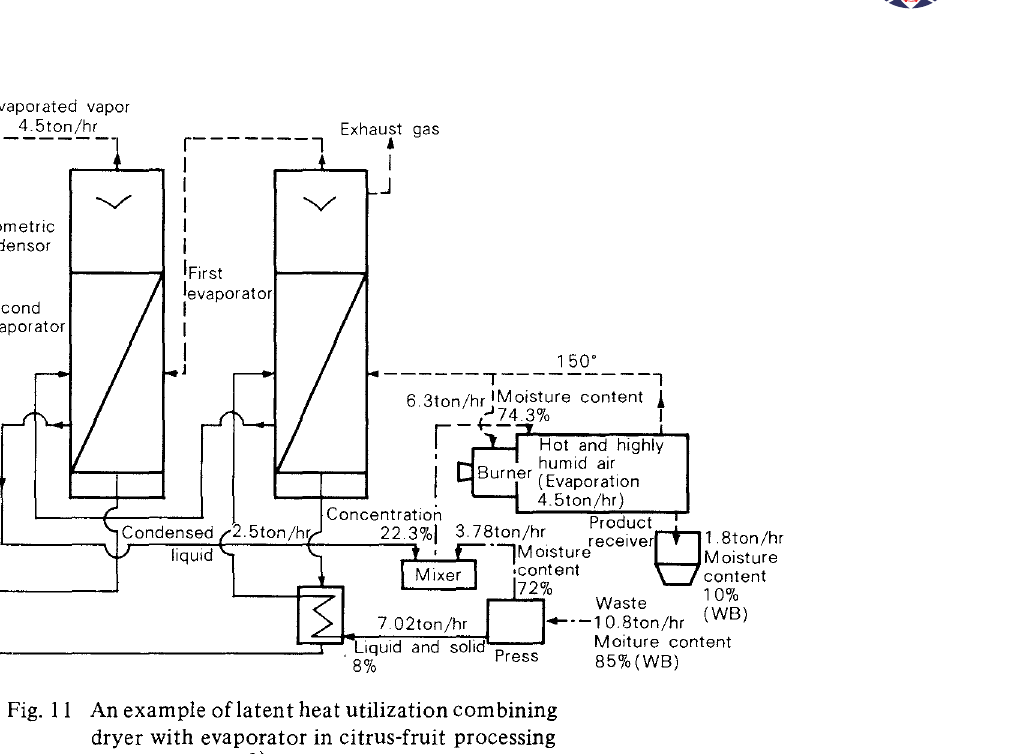
Fig_ II An example of latent heat utilization combining dryer with evaporator in citrus-fruit processing system in Japan 9)